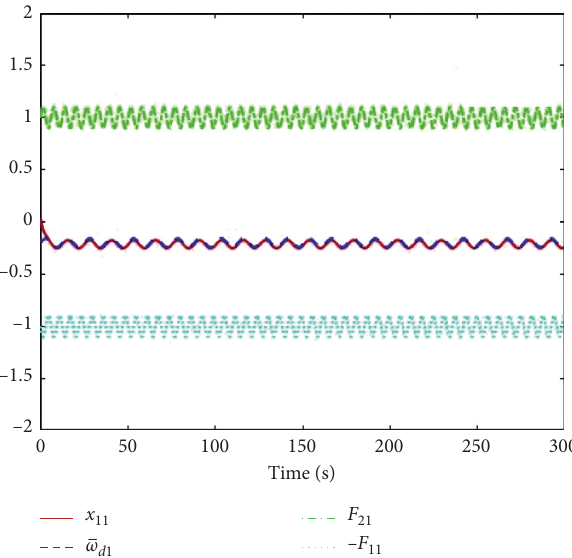
Figure 1: Trajectory of ϖ